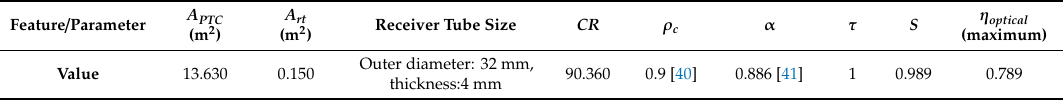
Table 7. Improved PTC desalination system design specifications for